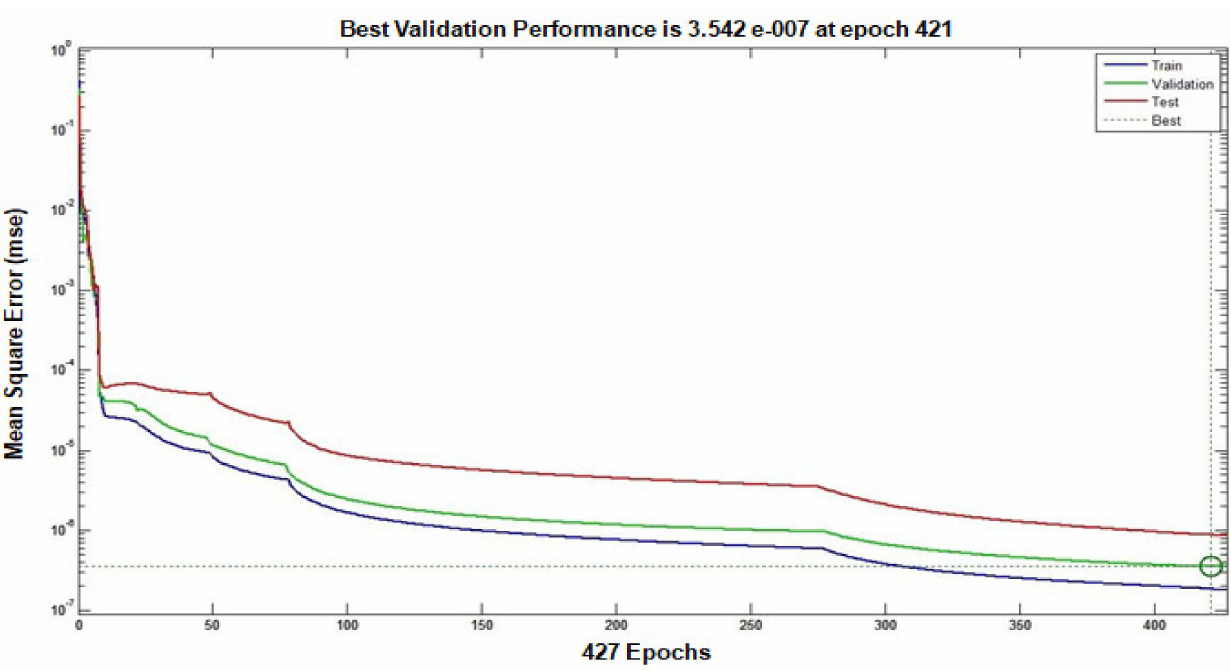
Figure 17. Performance graph of network 4-8-3 for angular distortion with time gap between two, three and four passes.